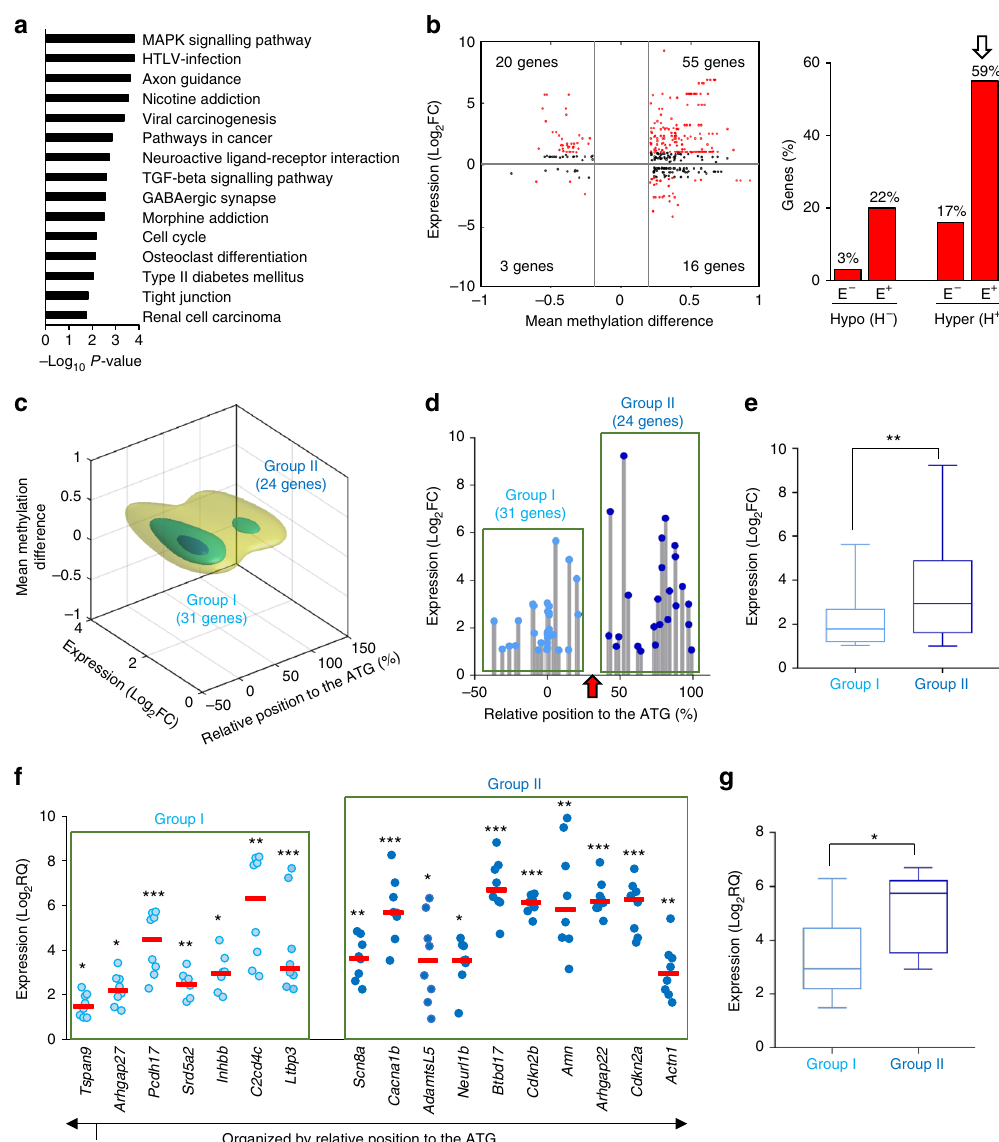
Fig. 3 Alb-R26 Met tumours are characterised by an enrichment in genes overexpressed and with hypermethylated CGIs. a Histogram reporting the KEGG pathway enrichment analysis for genes with changes in CGI methylation and expression in Alb-R26 Met tumours, ordered according to the − Log 10 P -value. b Left: Methylation differences versus expression for all genes with CGIs hypermethylated (H + ) or hypomethylated (H − ) in Alb-R26 Met tumours. Expression values are relative to controls. Dots correspond to single differentially methylated CpG and the corresponding gene expression (genes which expression is signi fi cantly below or above Log 2 FC ± 1 are indicated in red). Right: Graph reporting the percentage of downregulated (E − ) and upregulated (E + ) genes among those with a hypomethylated (H − ) or hypermethylated (H + ) CGI. Note the enrichment of genes overexpressed and with hypermethylated CGIs (indicated by an arrow), on which subsequent studies were focused. c For the 55 genes overexpressed and with hypermethylated CGI in Alb-R26 Met tumours, 3D density plot shows their distribution according to relative position to the ATG (as percentage), gene expression level (as Log 2 FC) and CGI methylation (as β -value difference). Note that genes segregate into two groups, according to their relative position to the ATG. d Graph reporting the individual expression level (as Log 2 FC; from RNA-seq data) of hypermethylated and overexpressed genes found in Alb-R26 Met tumours compare to controls. Note that the relative position of the hypermethylated CGI to the ATG well segregate the two groups (indicated with a red arrow). e Box plot illustrating the global expression levels of genes in Group-I and Group-II. f Graph reporting individual expression levels (as Log 2 FC; by RT-qPCR) of genes belonging to the two groups in Alb-R26 Met tumours ( n = 8) relative to control livers ( n = 6). Red lines report the median Log 2 FC in expression. Note that genes are distributed according to the location of the hypermethylated CGI relative to the ATG. g Box plot showing the global Log 2 FC in expression (according to data in F) of genes in Group-I and Group-II. In e and g , the median is reported by a line and bars extend to the minimum/maximum values. Signi fi cance is indicated on the top. * P < 0.05, ** P < 0.01, *** P <